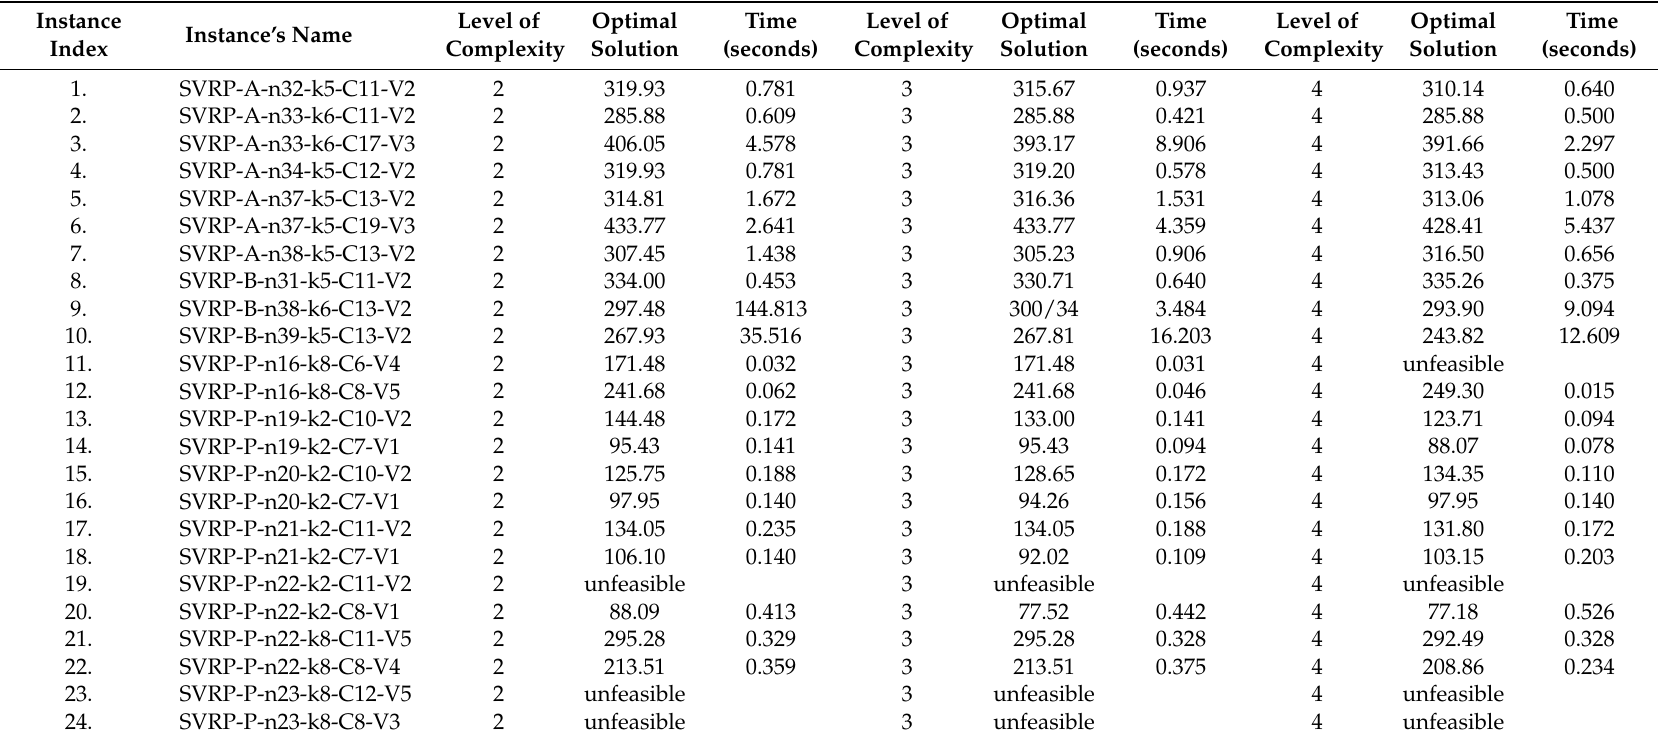
Table 3. Experimental results for solving small and medium SVRP instances with levels of complexity 2, 3 and